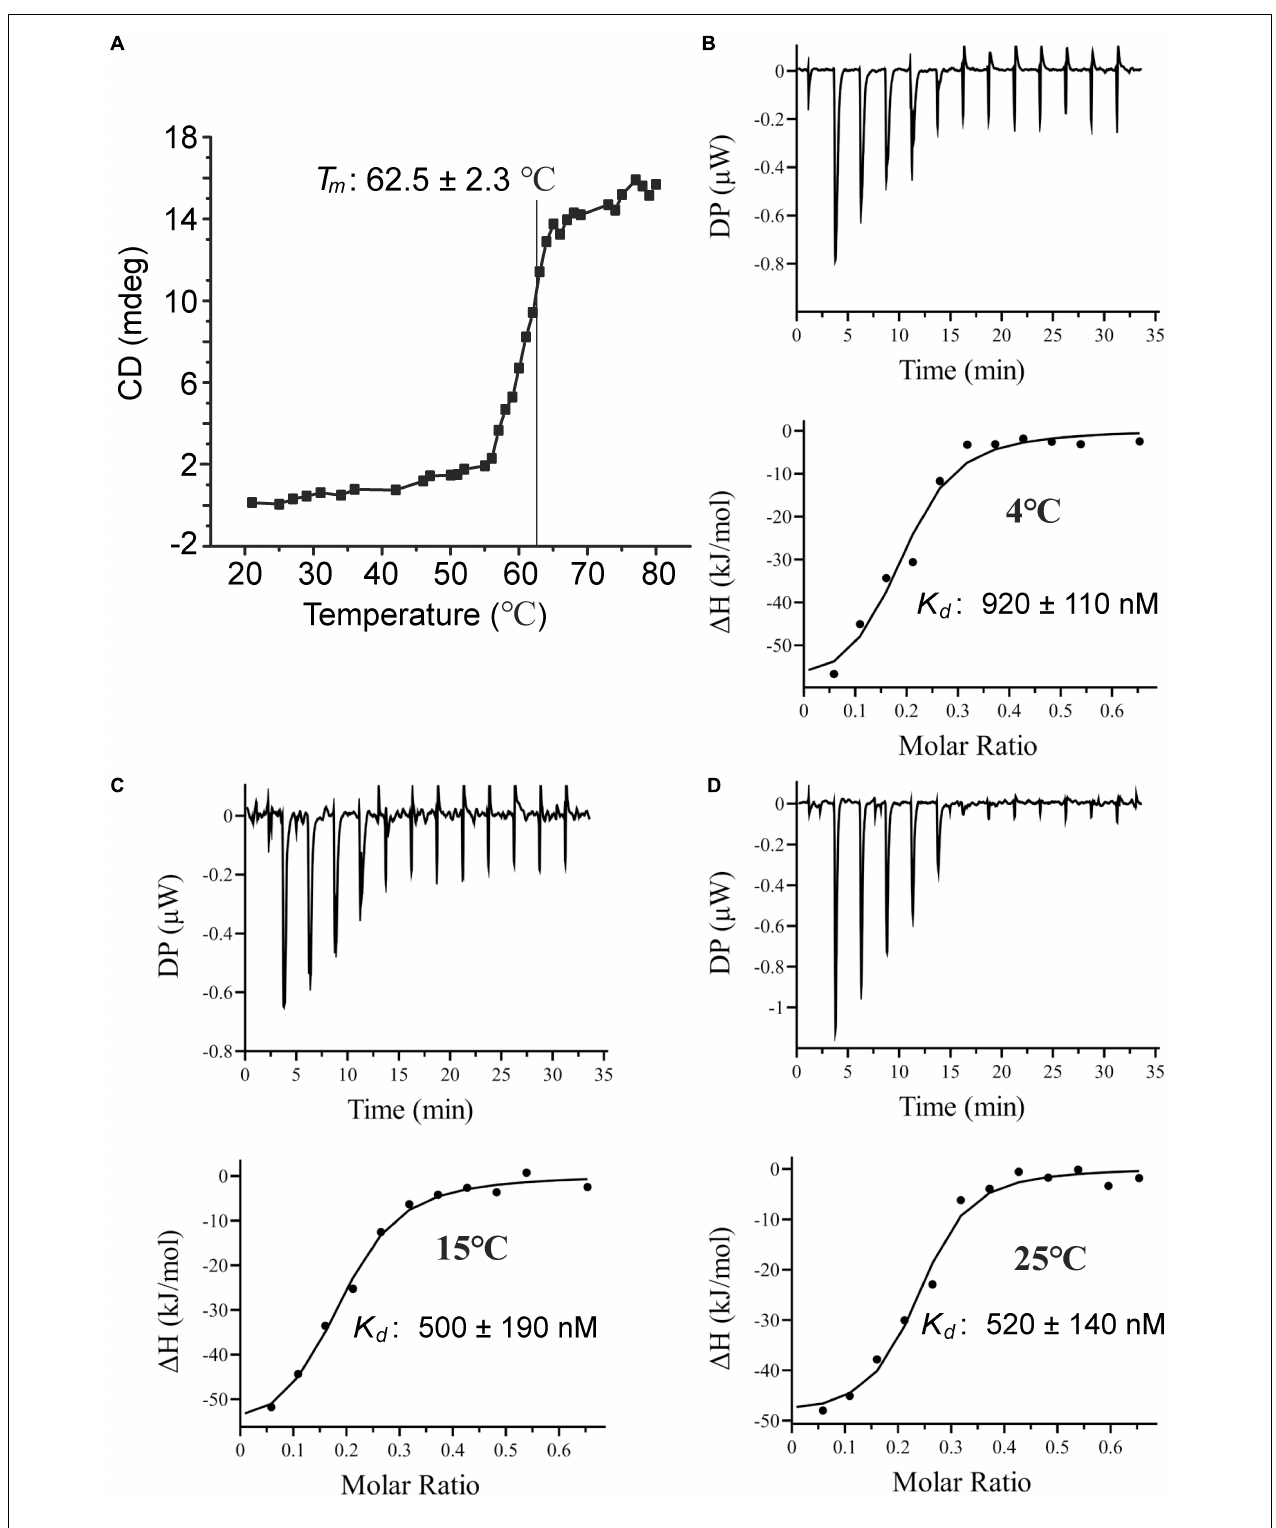
FIGURE 5 | Characterization of TmoX 1062 . (A) The T m of TmoX 1062 determined by CD. (B–D) ITC data for titrations of TMAO into TmoX 1062 at 4 ◦ C (B) , 10 ◦ C (C) , and 25 ◦ C (D) .